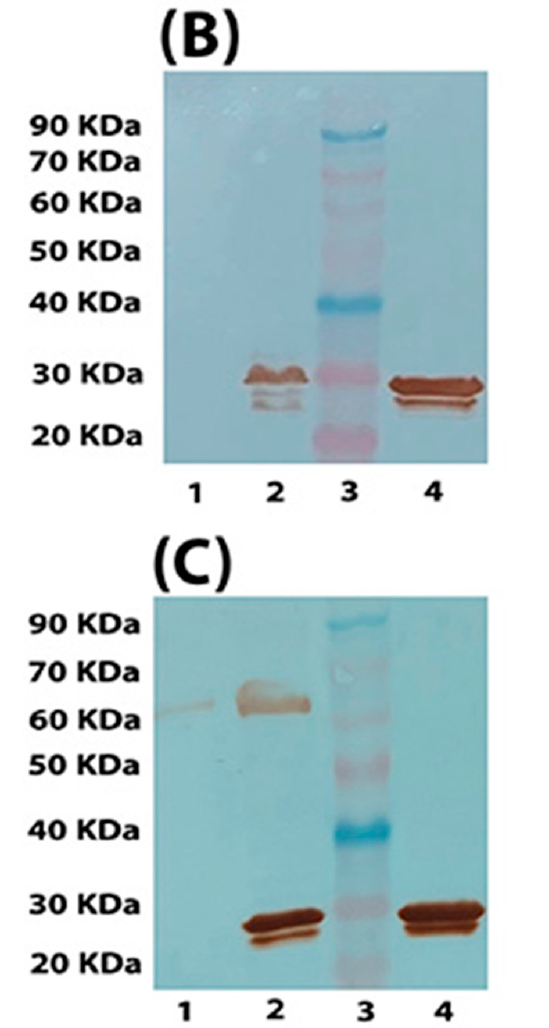
Figure 4. SDS-PAGE and Western blot of purified HasAp antigen. SDS-PAGE ( A ): Lane 1 is the induced culture lysate; lane 2 is the flow-through after passing the lysate through Ni-NTA agarose column; lane 3 is a sample from the second wash of the agarose resin; lane 4 is the pre-stained protein ladder; lanes 5, 6, and 7 are three successive eluates (E1 through E3) of purified His-tagged HasAp recombinant antigen (apparent molecular weight of 28 kDa). Western blot: The primary antibody is anti-His tag antibodies ( B ) or mouse polyclonal antibodies raised following sub-lethal dose injection of PA ATCC 9027 in mice ( C ). In both ( B ) and ( C ), lanes 1, 2, 3, and 4 represent non-induced lysate, induced lysate, pre-stained protein ladder, and HasAp protein band at an apparent molecular weight of 28 kDa, respectively. In ( C ), a non-specific, non-His-tagged protein band appears at an apparent molecular weight of 65